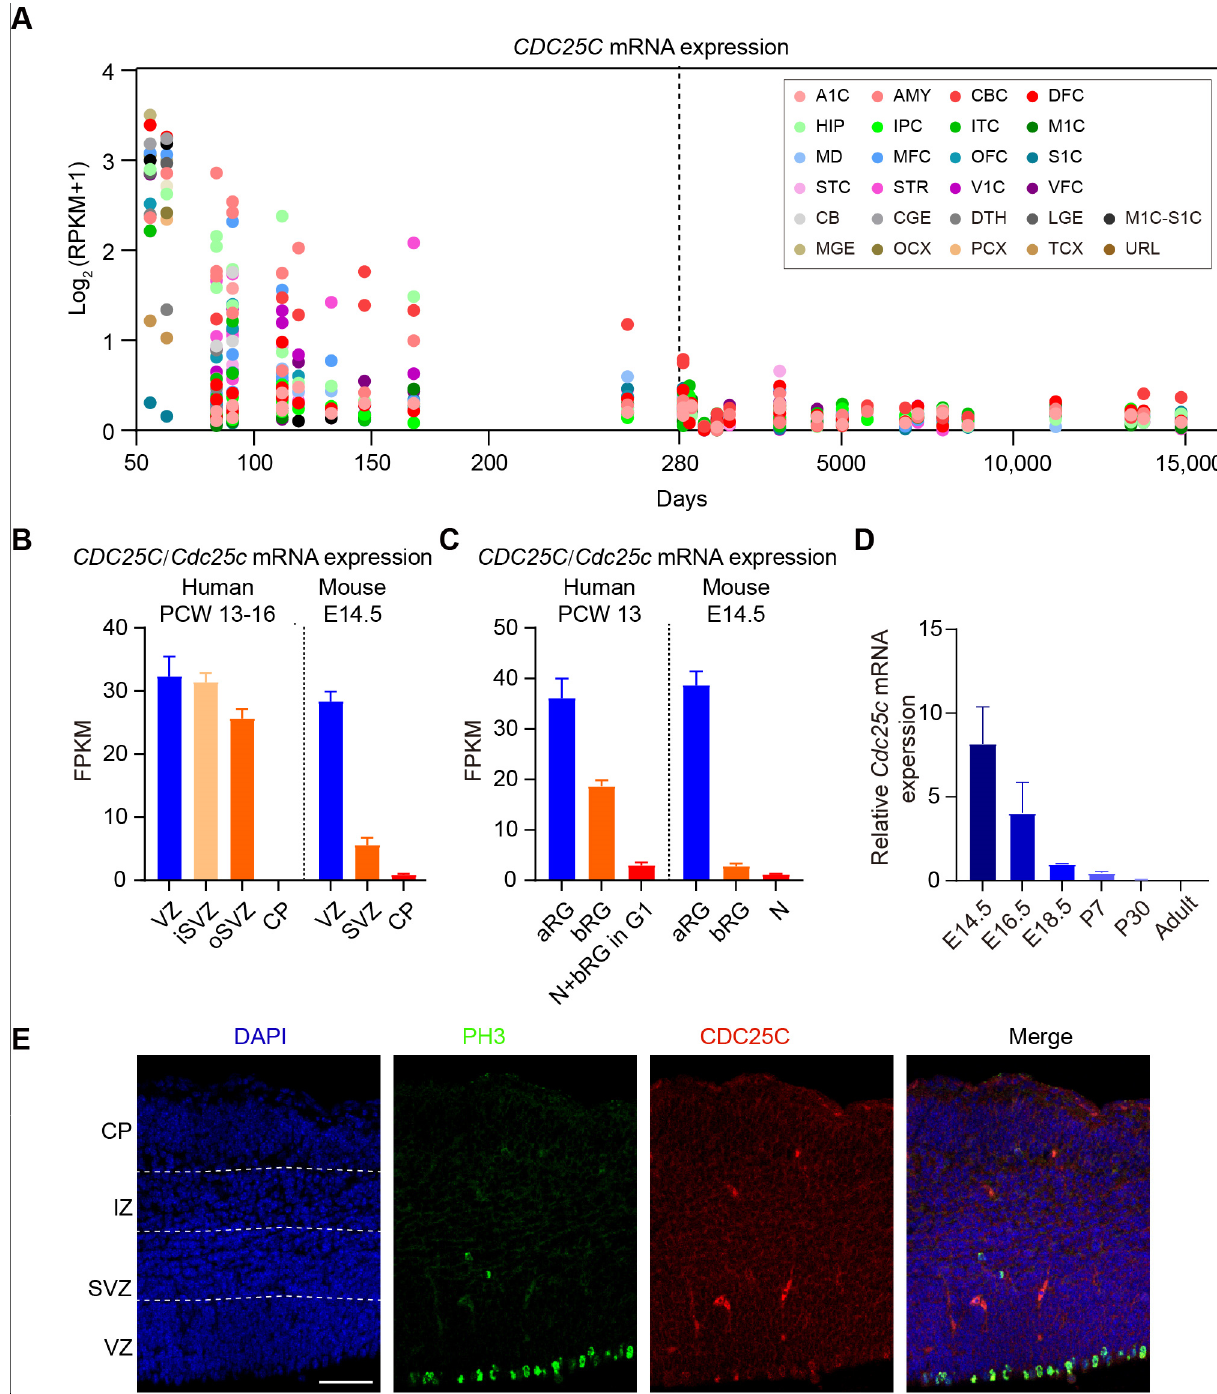
Figure 1. CDC25C is highly expressed in early brain and NPCs. ( A ) mRNA level of CDC25C across pre-natal and postnatal periods from BrainSpan data. The X-axis represents the age of samples in days and Y-axis represents the log 2 (RPKM + 1). The dashed line shows the day of birth. A1C, primary auditory cortex; AMY, amygdaloid complex; CBC, cerebellar cortex; DFC, dorsolateral prefrontal cortex; HIP, hippocampus; IPC, inferior parietal cortex; ITC, inferolateral temporal cortex; M1C, primary motorcortex; MD, mediodorsal nucleus of thalamus; MFC, medial prefrontal cortex; OFC, orbital frontal cortex; S1C, primary somatosensory cortex; STC, superior temporal cortex; STR, striatum; V1C, primary visual cortex; VFC, ventrolateral prefrontal cortex; CB, cerebellum; CGE, caudal